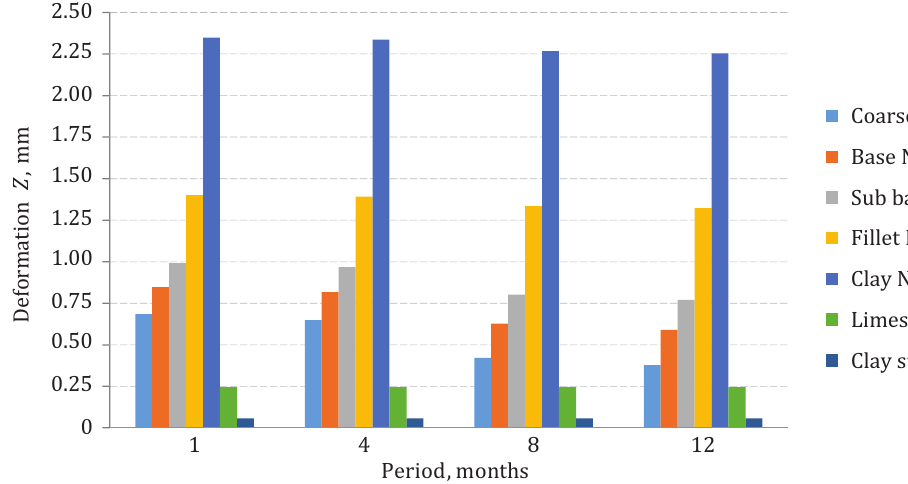
Figure 19. Lateral deformation ( z )-time changes of the layers for N type